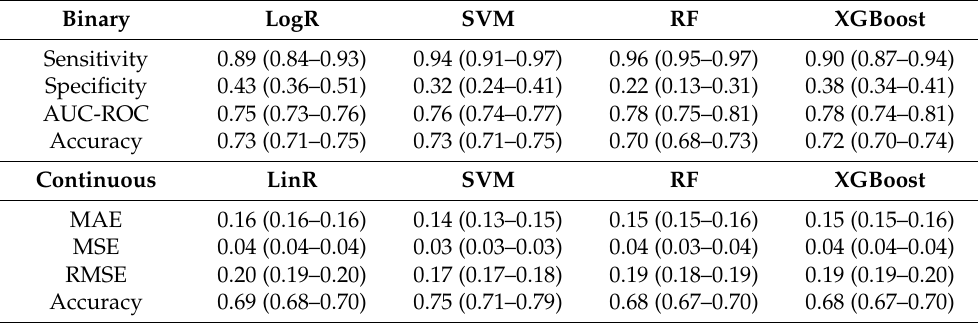
Table 2. The model performance of the binary and continuous outcomes between different algorithms in inpatient test